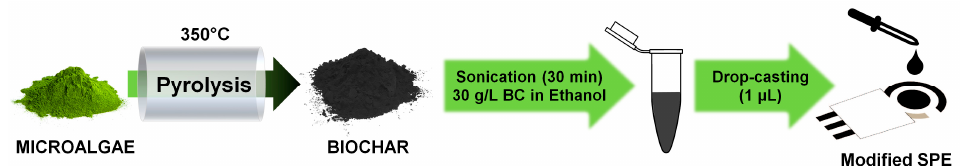
Figure 1. Sketch representation of the steps involved in the modification of the screen-printed elec- trode with biochar.